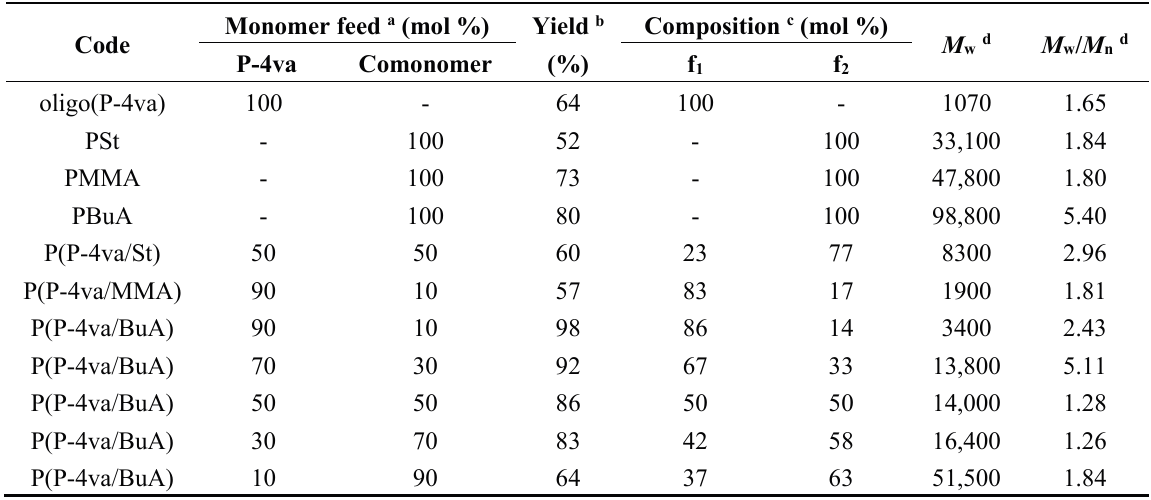
Table 1. Radical copolymerization of P-4va with vinyl monomers in benzene at 60 °C for 24 h.